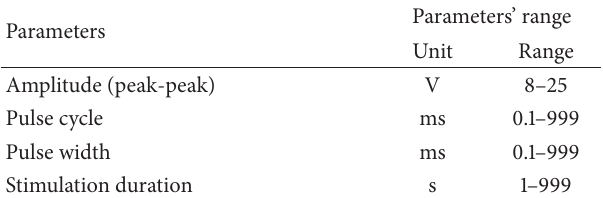
Figure 2: Stimulation pulses.